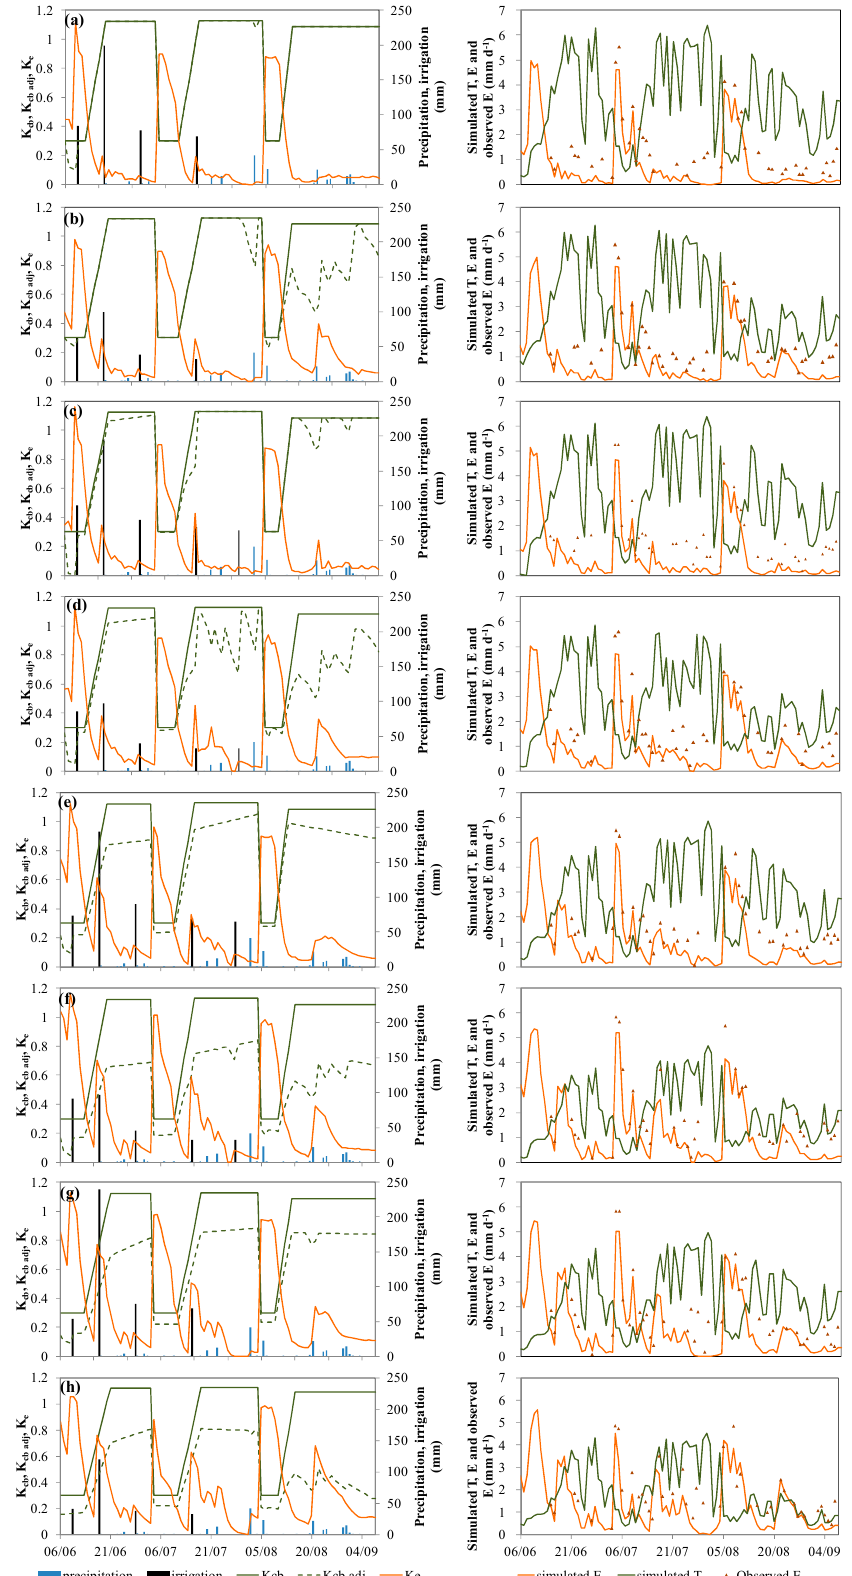
Figure 4. Seasonal variations of soil evaporation coefficient ( K e ), basal crop coefficient ( K cb ), adjusted K cb ( K cb adj ), precipitation and irrigation during the whole growth period of alfalfa in 2018. On the right panel, the simulated crop transpiration ( T ), soil evaporation ( E ) and observed E for the alfalfa were shown. ( a )–( h ): W1S0, W2S0, W1S2, W2S2, W1S4, W2S4, W1S6 and W2S6.